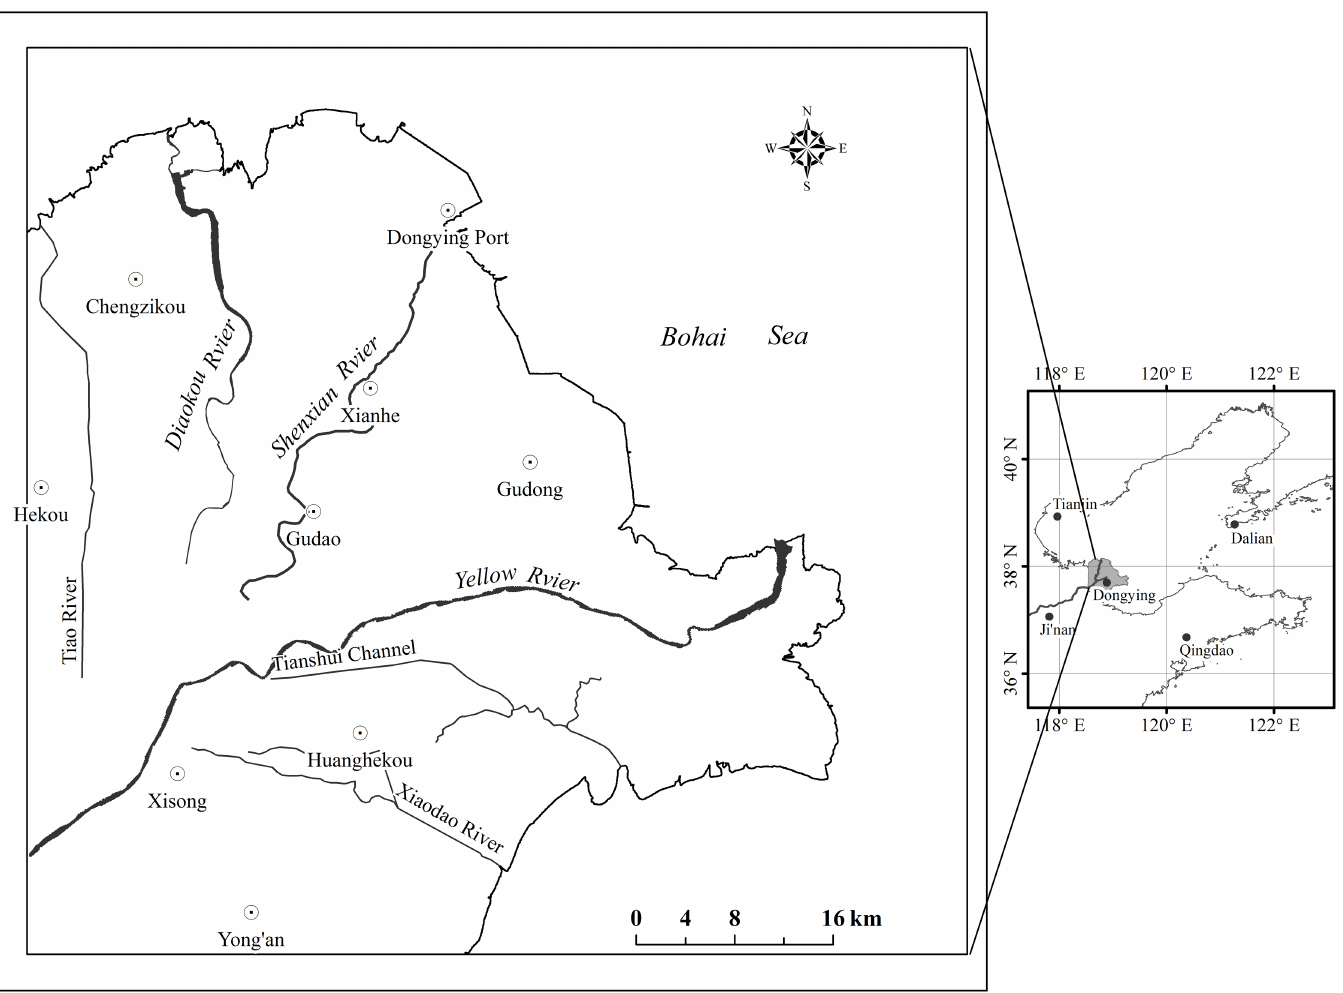
Fig 1. Study area of the Yellow River